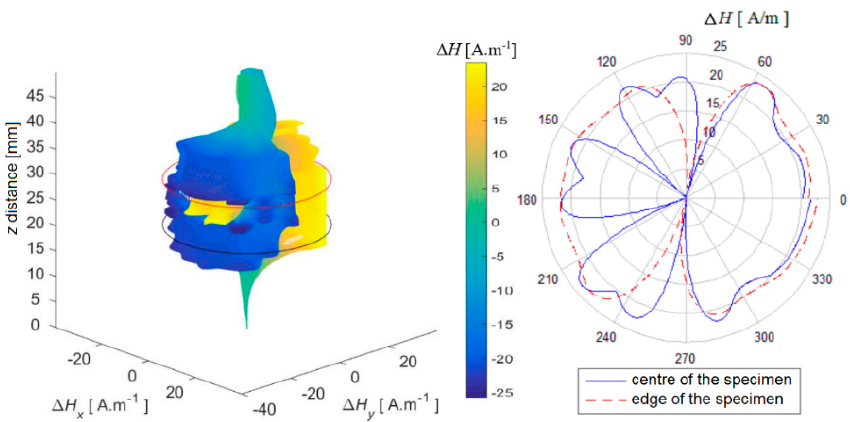
Figure 15. Reconstruction of the magnetic field of the shell. AISI 316Ti, PD = 40%.